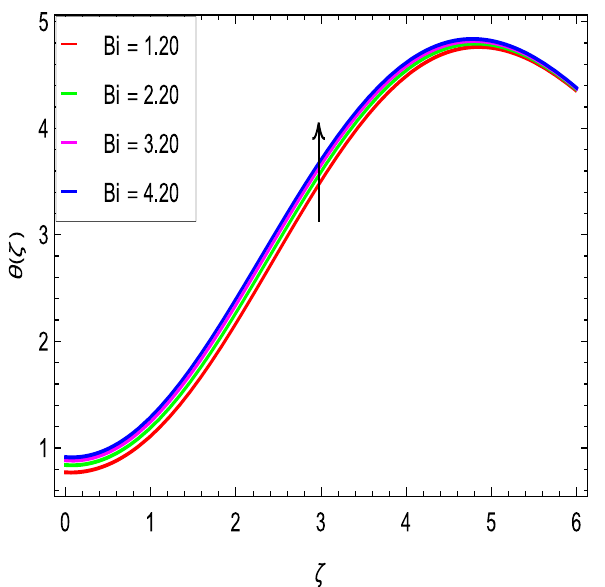
Figure 14. θ(ζ) in terms of Bi .